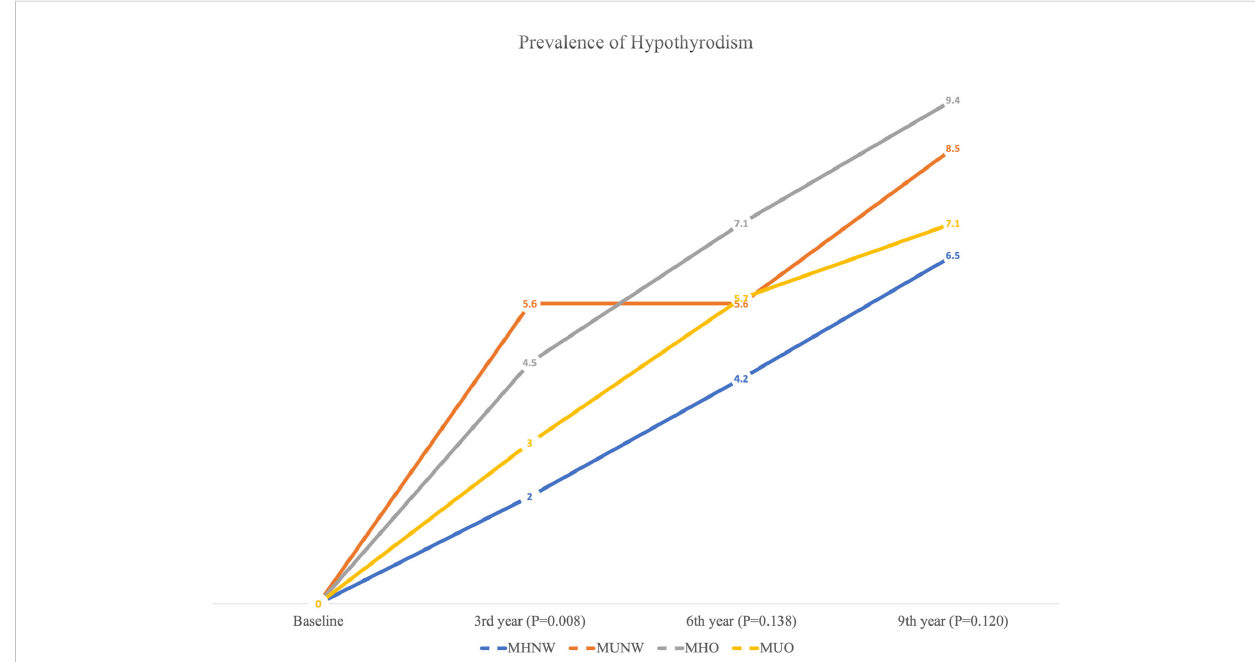
FIGURE 2 Prevalence of hypothyroidism according to different metabolic phenotypes in the total